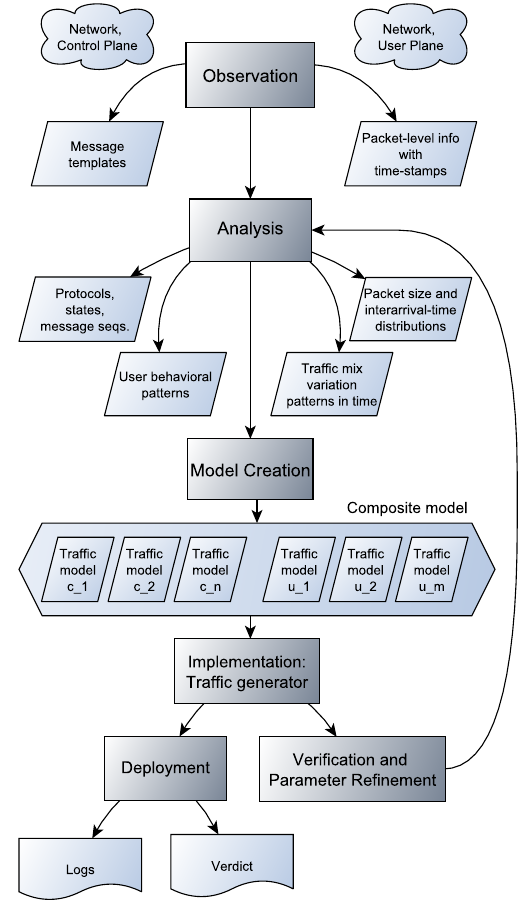
Figure 5. Tasks and their results in the methodology. Shaded gray rectangles illustrate procedures; parallelograms represent intermediate data